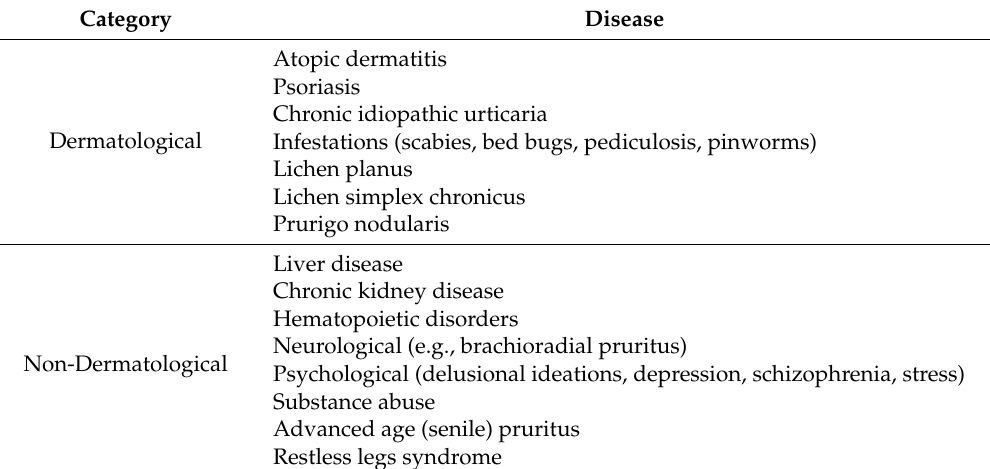
Table 2. Common causes of nocturnal